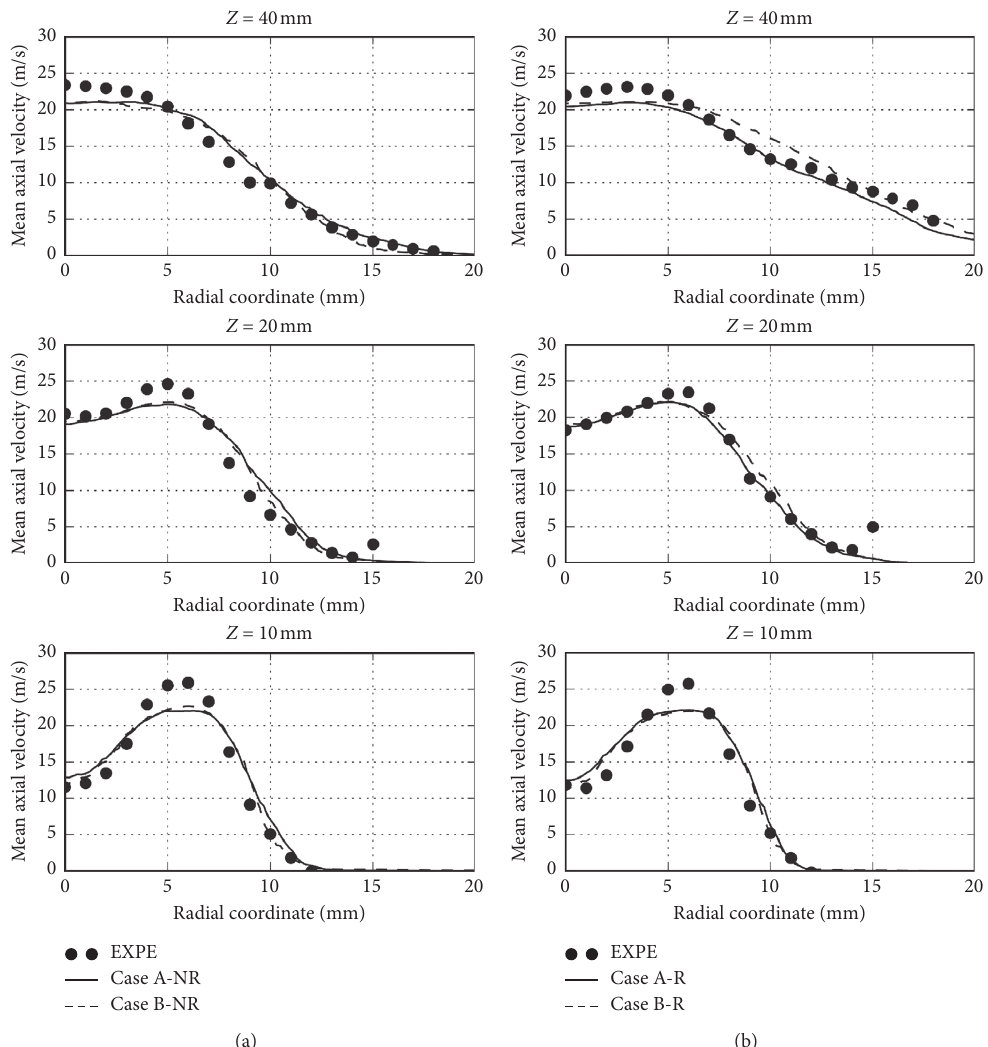
Figure 10: Radial profiles of mean axial velocity for nonreacting (a) and reacting case (b). Symbols: experiments, solid line: Case A dashed line: Case